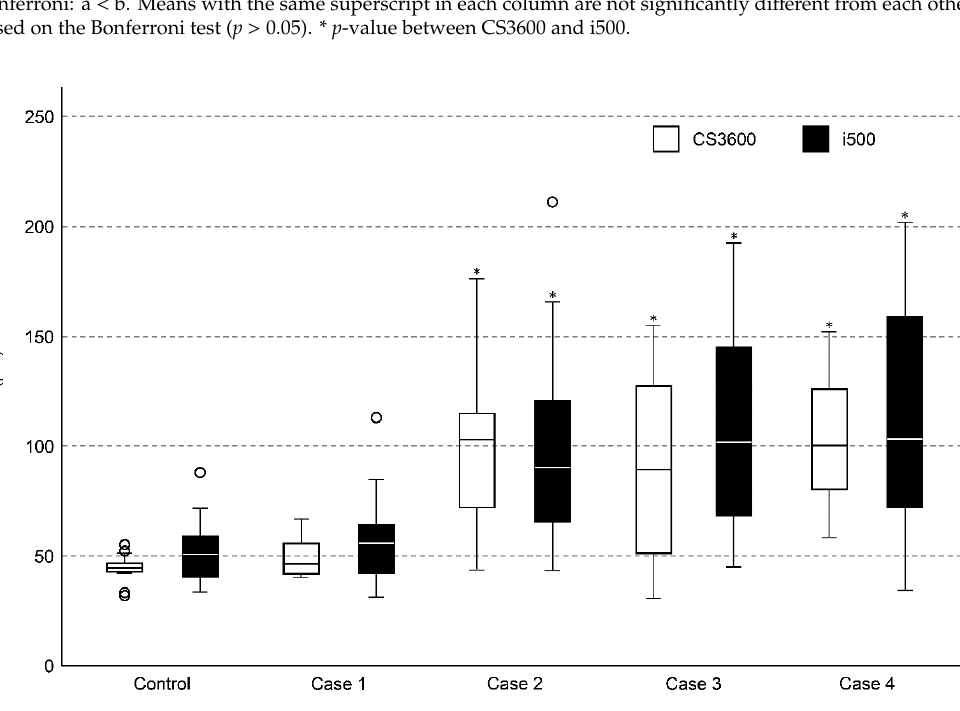
Figure 2. Box plot demonstrating precision measurement. The amount of deviation is represented as root mean square (RMS). * Significantly different from control group scanned with the same intraoral scanner ( p ≤ 0.05).